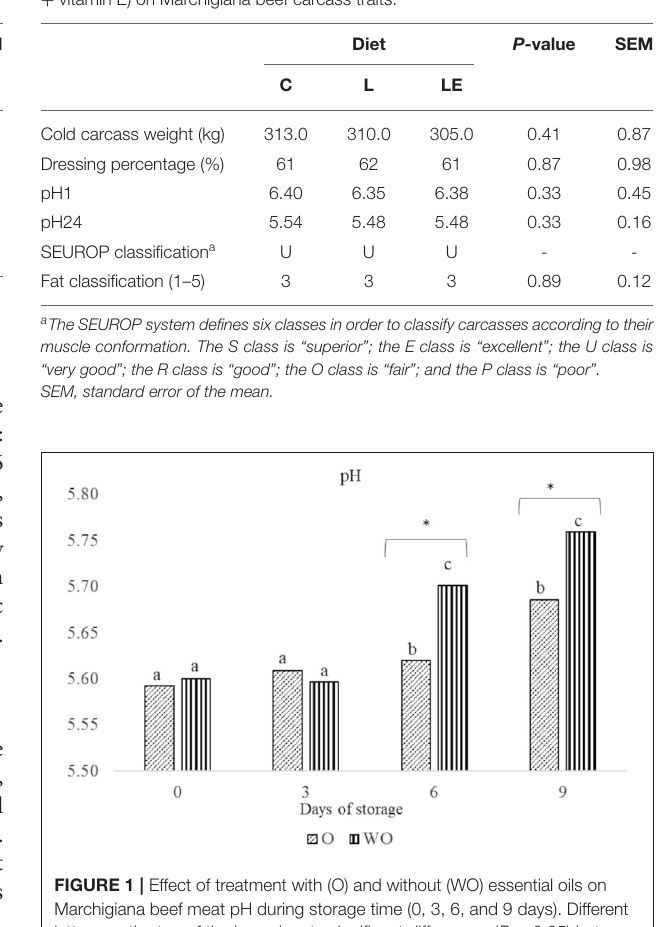
TABLE 3 | Effect of the experimental diets C (Control), L (Linseed), and LE (linseed + vitamin E) on Marchigiana beef carcass traits.